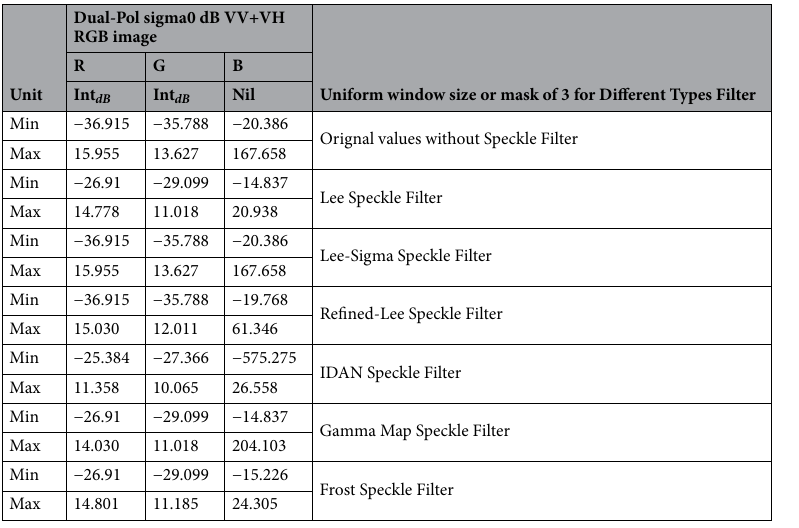
Table 10. Statistical summary of σ 0 values in different bands for different